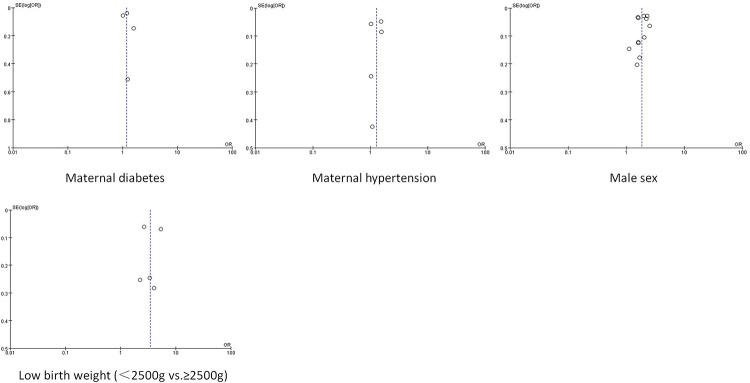
Funnel plot for publication bias test (Continued).The two oblique lines indicate the pseudo 95% confidence limits.